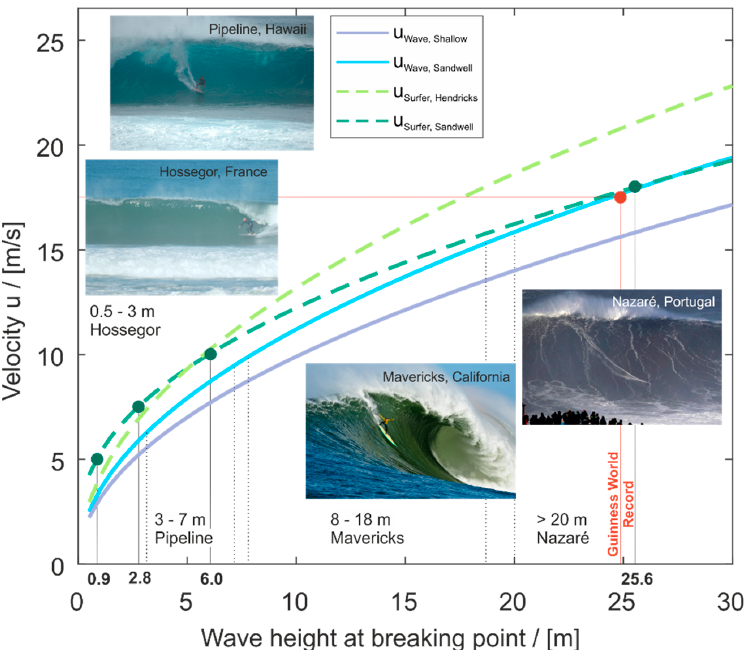
Figure 1. The velocity of the surfer (dashed lines) and the wave (solid lines) versus the wave height at the breaking point of the wave. The green dots show the simulated inflow velocities of 5, 7.5, 10, and 18 m/s, which were used in this study, and the corresponding wave heights of 0.9, 2.8, 6.0, and 25.6 m. The red dot shows the Guinness World Record of Rodrigo Koxa in 2017 with the confirmed wave height of 24.38 m (80 ft.). The small subfigures show corresponding waves of Hossegor (France), Pipeline (Hawaii), Mavericks (California), and Nazaré (Portugal) in order of the maximum reachable wave height.